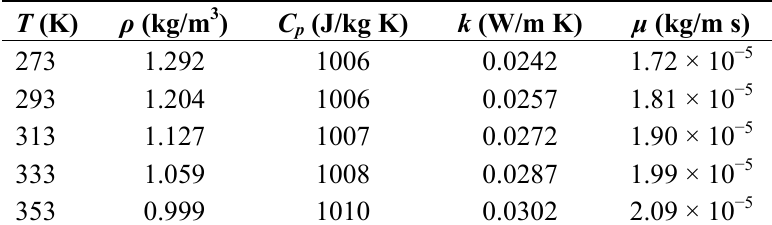
Table 1. Physical properties of air at 1 atm